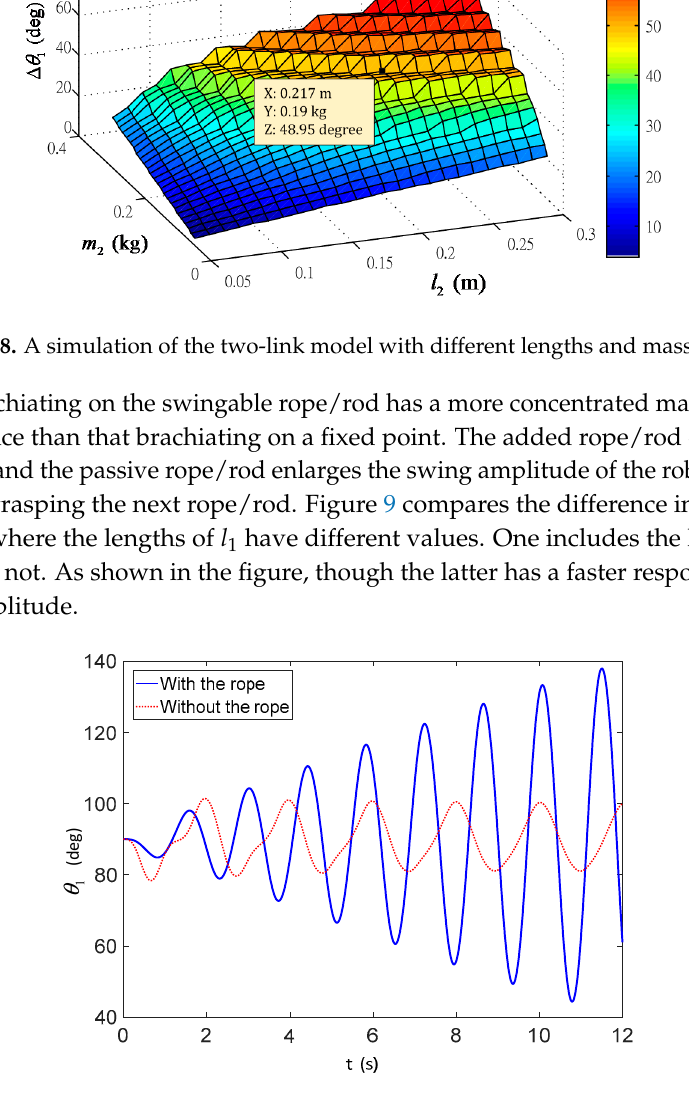
Figure 9. The swing amplitudes of the robot grasping the fixed point and the rod.